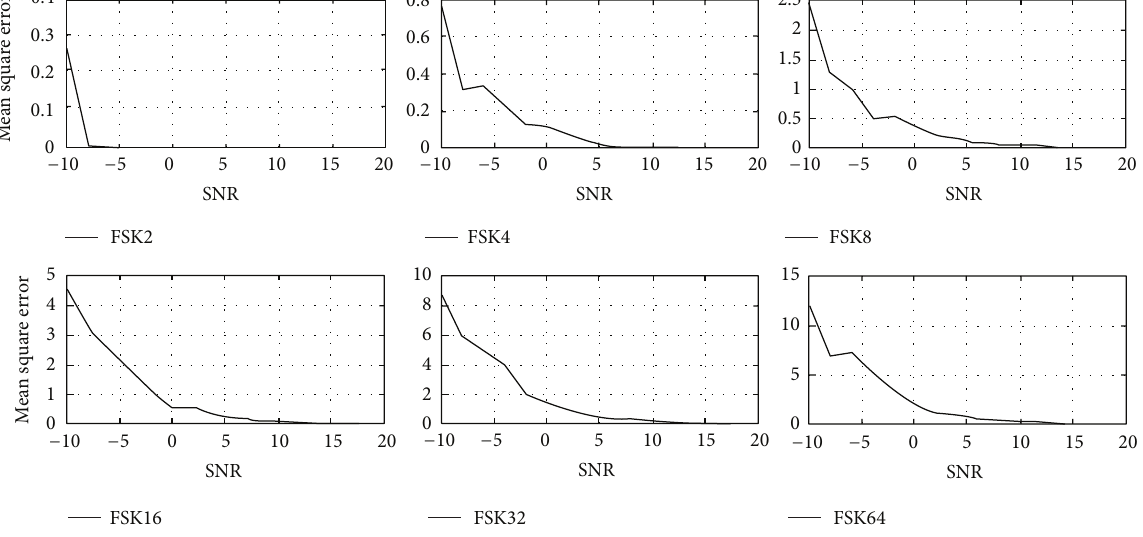
Figure 9. The parameters of Gabor filter network and weights of the adaptive filter are updated and mean square error is minimized as SNR is increased from 0 to 20